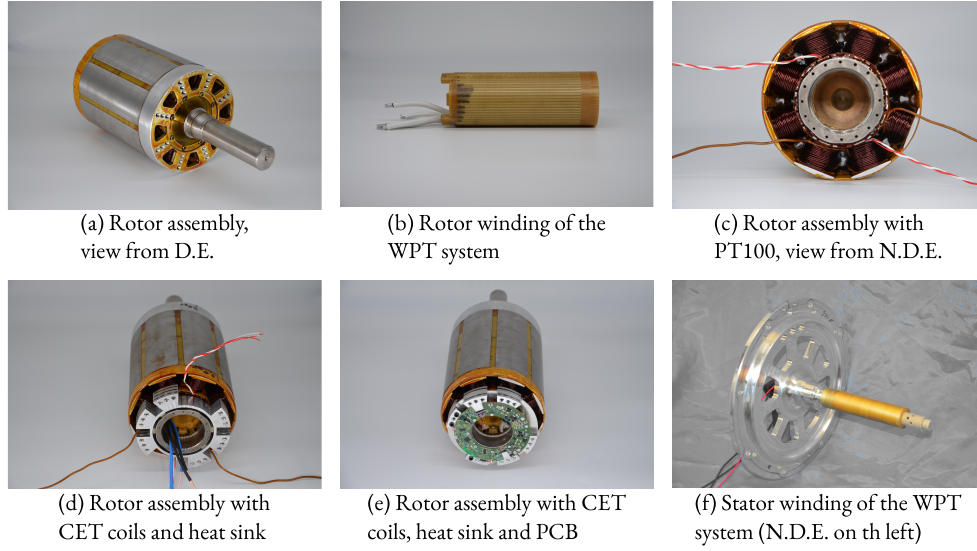
Figure 14. Integration of the WPT system of the prototype at different manufacturing states.